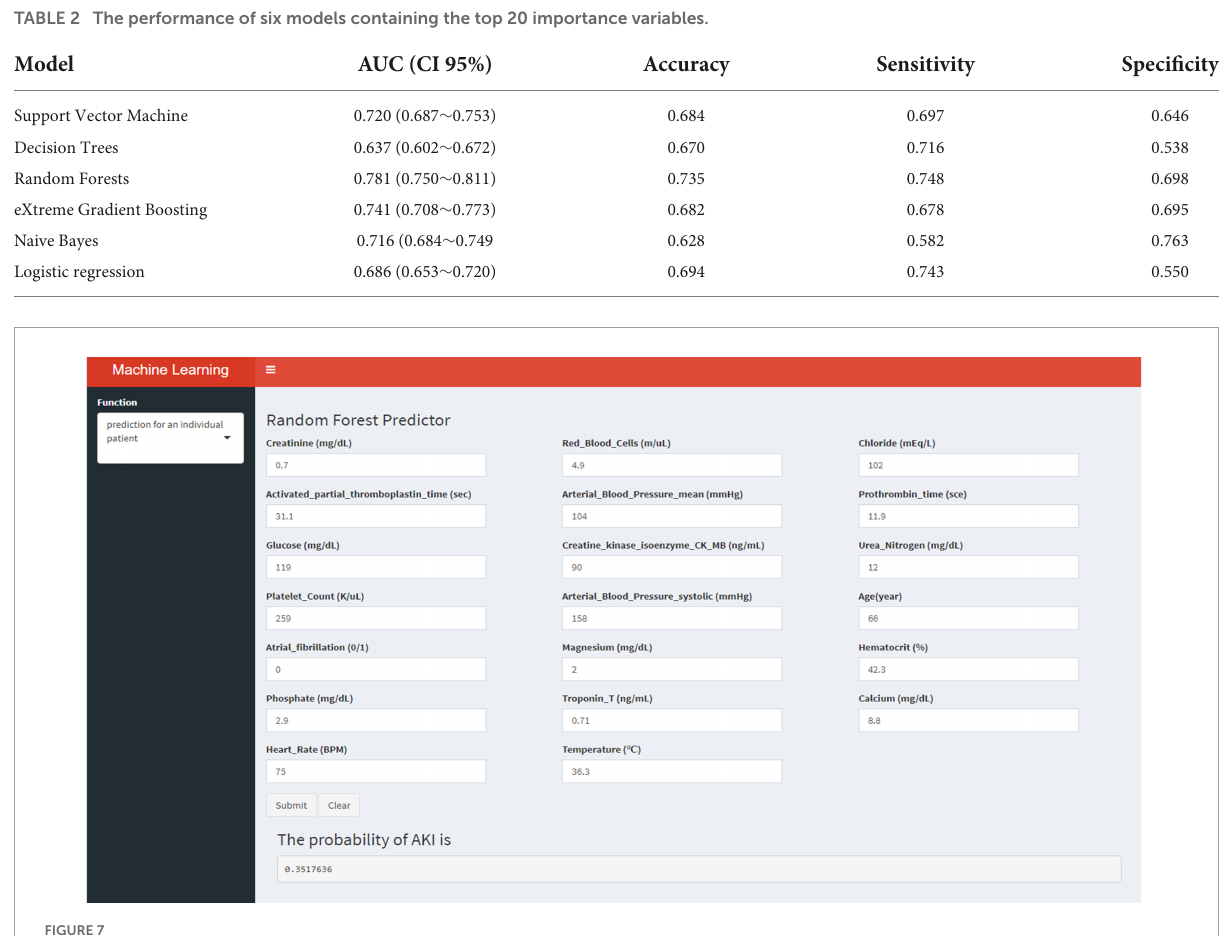
FIGURE7 An example of the application software for predicting AKI risk in AMI